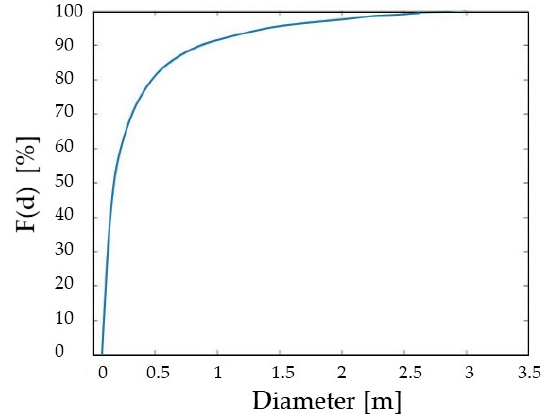
Figure 3. An example of a cumulative distribution function (CDF) obtained for D = − 1.75, a = 0.075 m, and b = 3 m.